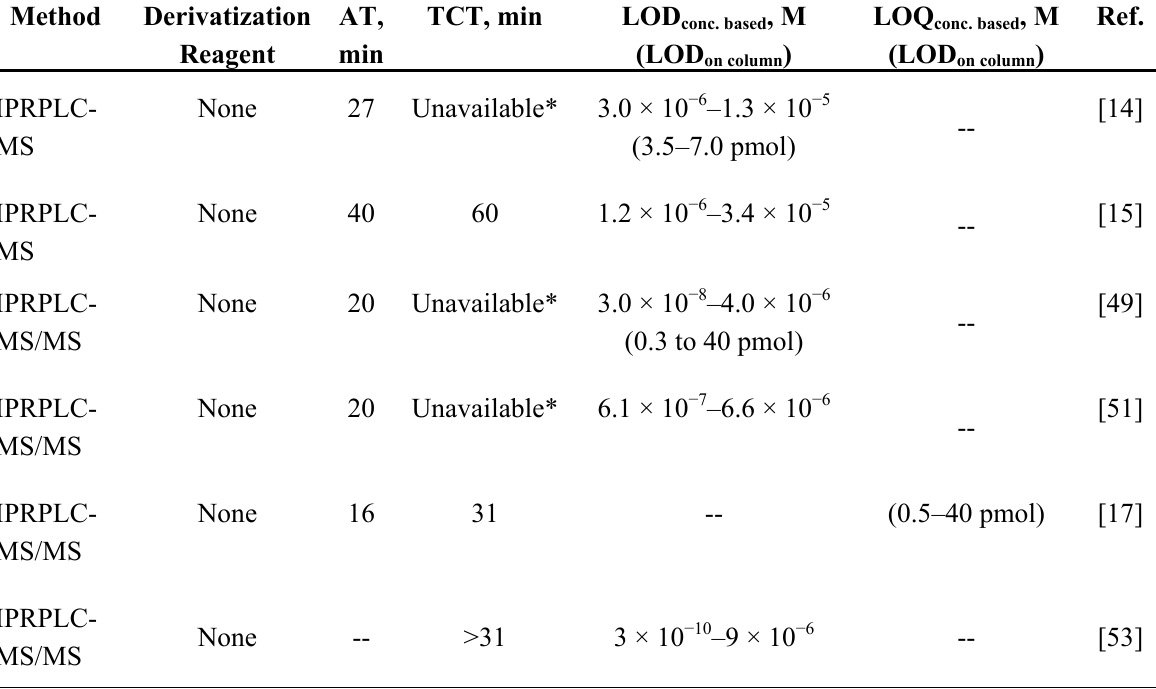
Table 4. Comparison on the sensitivity of selected LC/MS-based approaches for amino acid